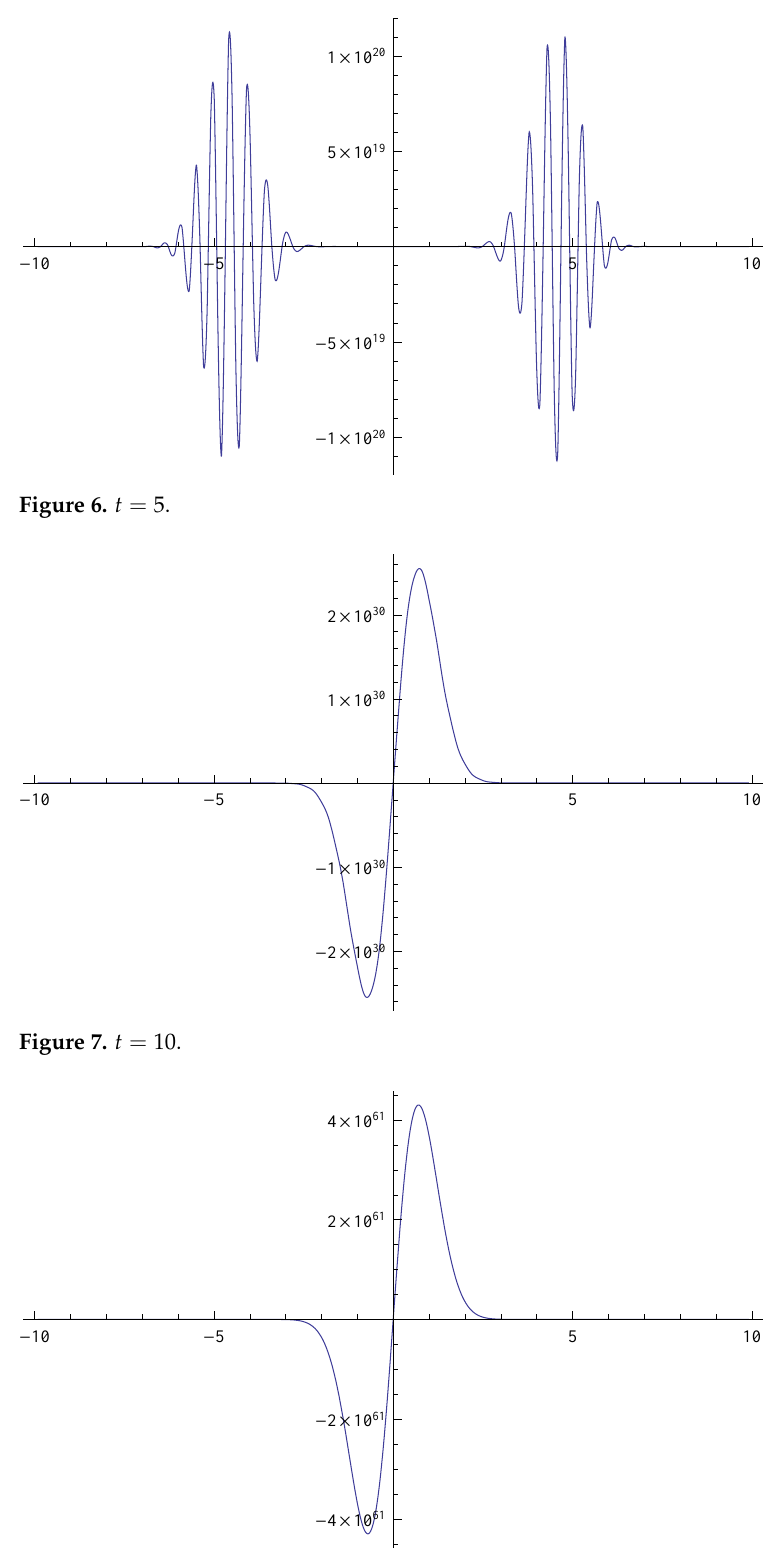
Figure 8. t = 20. The time evolution of the approximate solution of Equation (5) is as a ( x ) = a = 1, b ( x ) = − bx = − x , k = 1, γ = 2, β = 1.7, α = 0.7, r = 100, and f ( x ) = sin π x